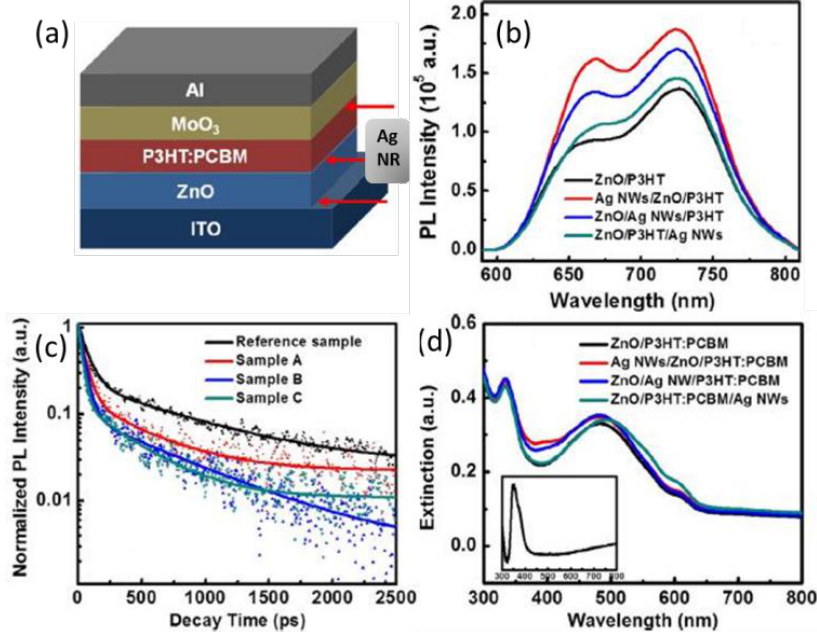
Figure 20. ( a ) Device architecture of the reference inverted PSCs (without Ag NWs) or the plasmonic inverted PSCs (with Ag NRs); ( b ) PL spectra of the reference and plasmonic samples recorded using excitation source wavelengths of 500 nm; ( c ) PL decay profiles for the P3HT:PCBM blends in the reference and plasmonic samples. Excitation source: 500 nm pulsed laser; ( d ) extinction spectra of the reference and plasmonic samples. Inset shows extinction spectrum of Ag NWs [79]. Reprinted with permission from Ref. [79].